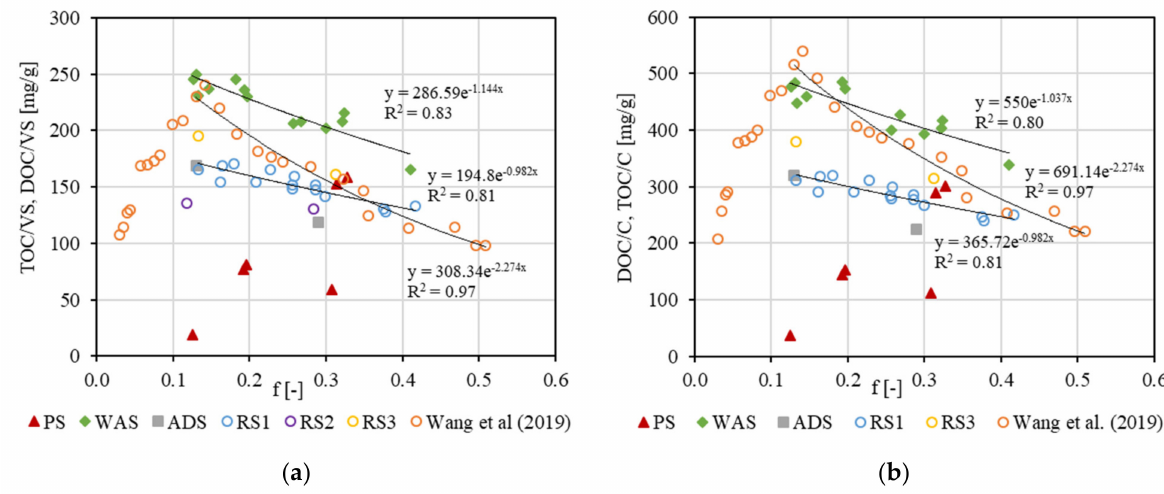
Figure 6. Curves of the ratio ( a ) DOC/VS (TOC/VS: data adapted from Wang et al. [24]) and ( b ) DOC/C (TOC/C: data adapted from Wang et al. [24]) with an increasing reaction intensity during the hydrothermal treatment of various sewage